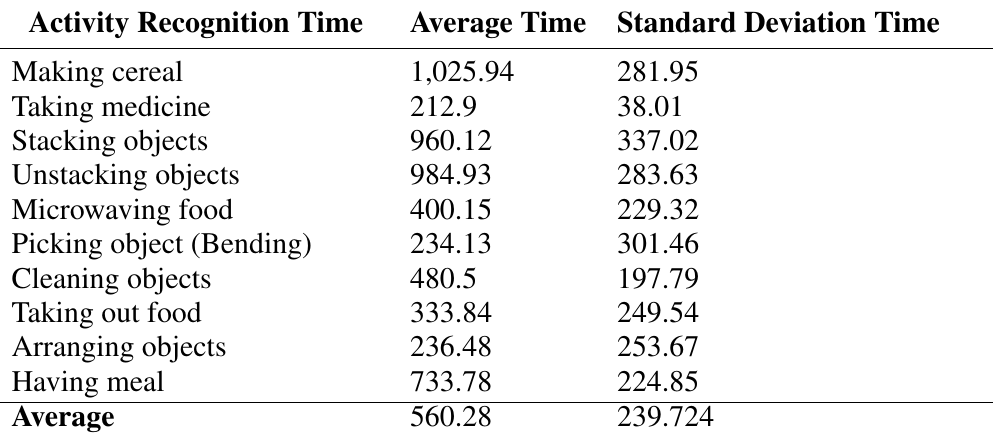
Table 16. Average recognition times (in milliseconds) per high-level